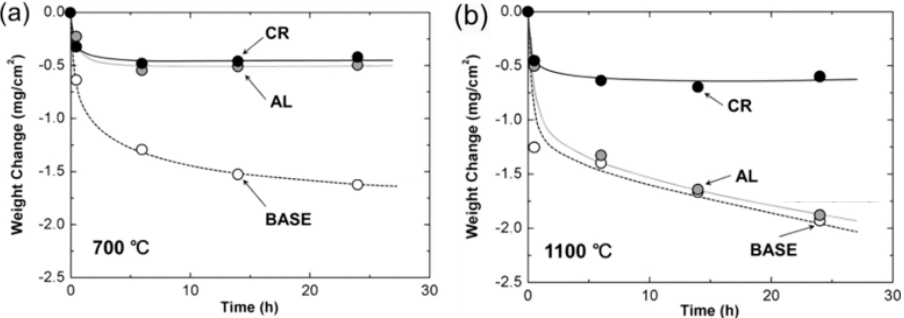
Figure 19. Weight change curves of different samples: ( a ) oxidized at 700 °C; ( b ) oxidized at 1100 °C. Reproduced with permission [80]. Copyright 2020 Elsevier.